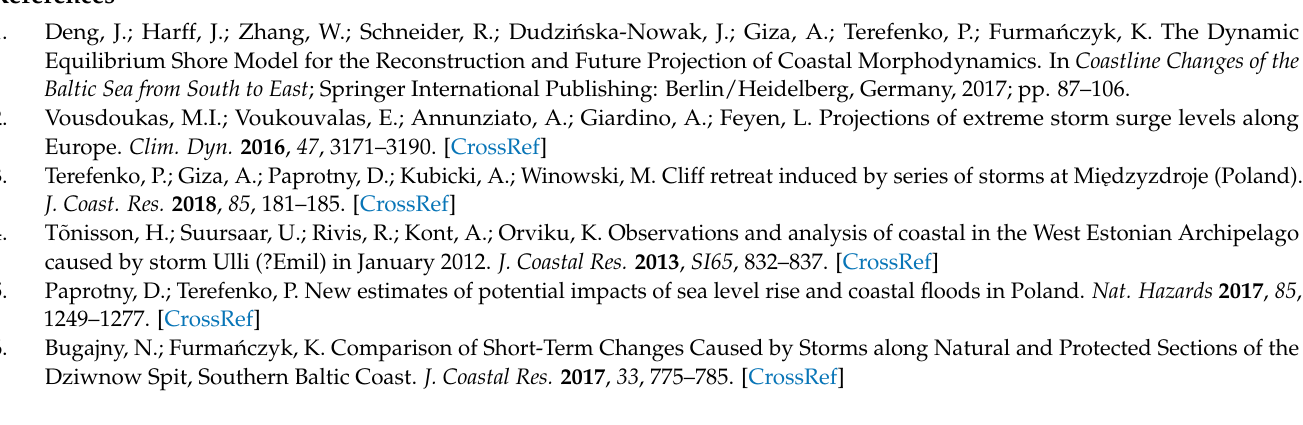
Table S2: Land cover area percentages in each year for areas no. 18–36 [%], Table S3: Land cover area percentages in each year for areas no. 37–51